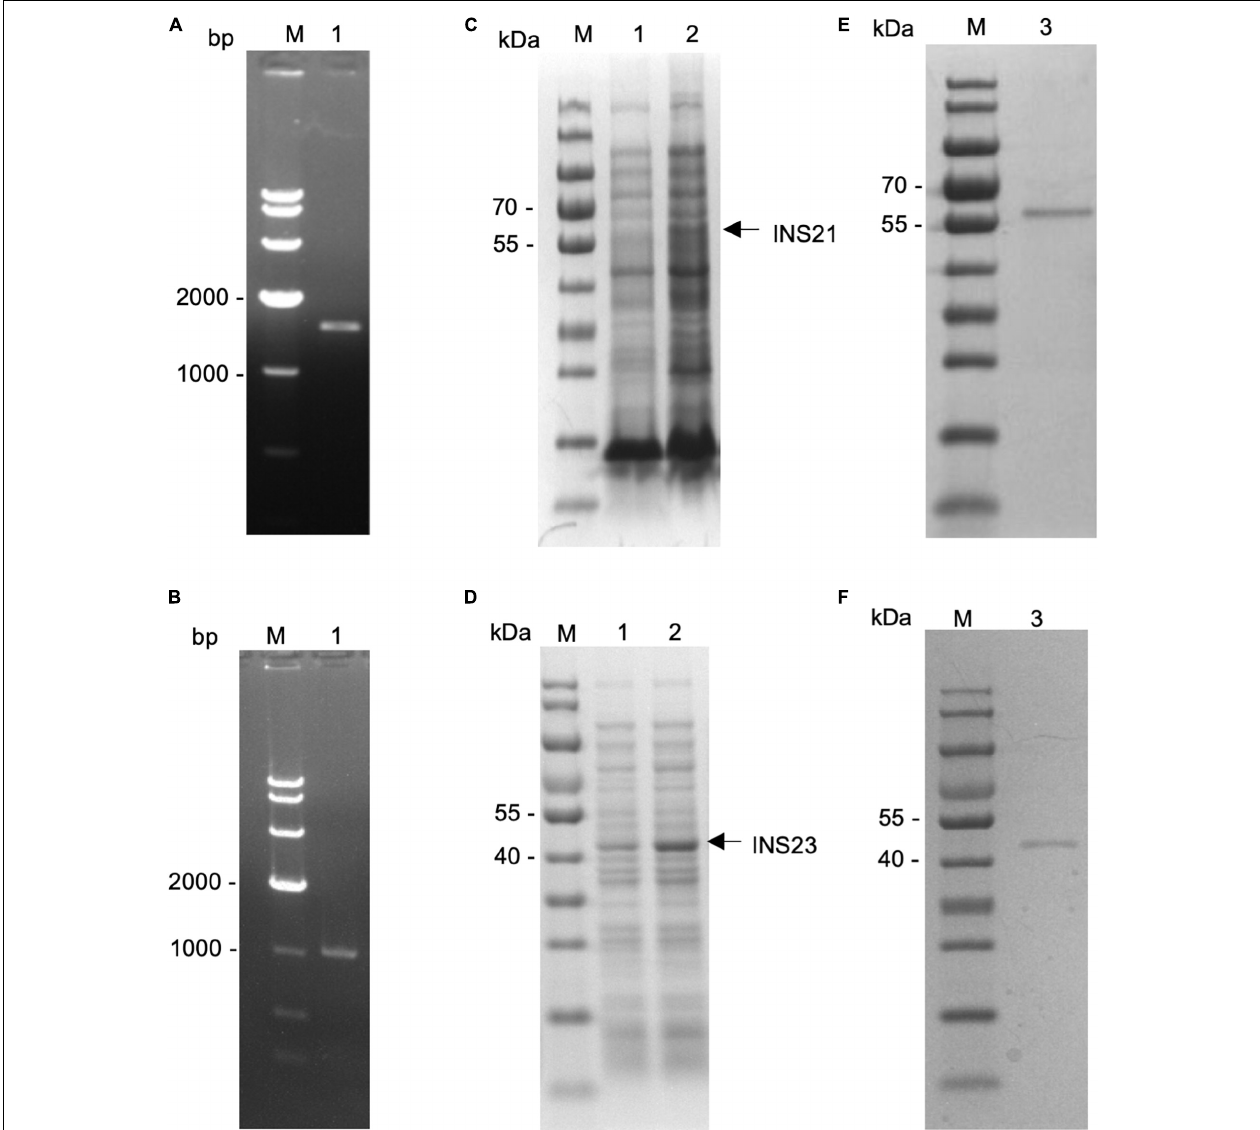
FIGURE 2 | Expression of recombinant INS-21 and INS-23 in Escherichia coli . PCR amplification of the INS-21 gene (A) and INS-23 gene (B) of Cryptosporidium parvum . Lane M: 1000-bp molecular makers; Lane 1: PCR product. SDS-PAGE analysis of INS-21 protein (C) and INS-23 protein (D) expressed in E. coli . SDS-PAGE analysis of purified INS-21 protein (E) and INS-23 protein (F) from E. coli . Lane M, molecular weight markers; Lane 1, lysate from recombinant bacteria without the isopropyl β -D-thiogalactoside (IPTG) induction; Lane 2, lysate from recombinant bacteria after the IPTG induction, with the expected product being indicated by an arrow; Lane 3, purified recombinant proteins from the E. coli lysate using Ni-NTA affinity chromatography.